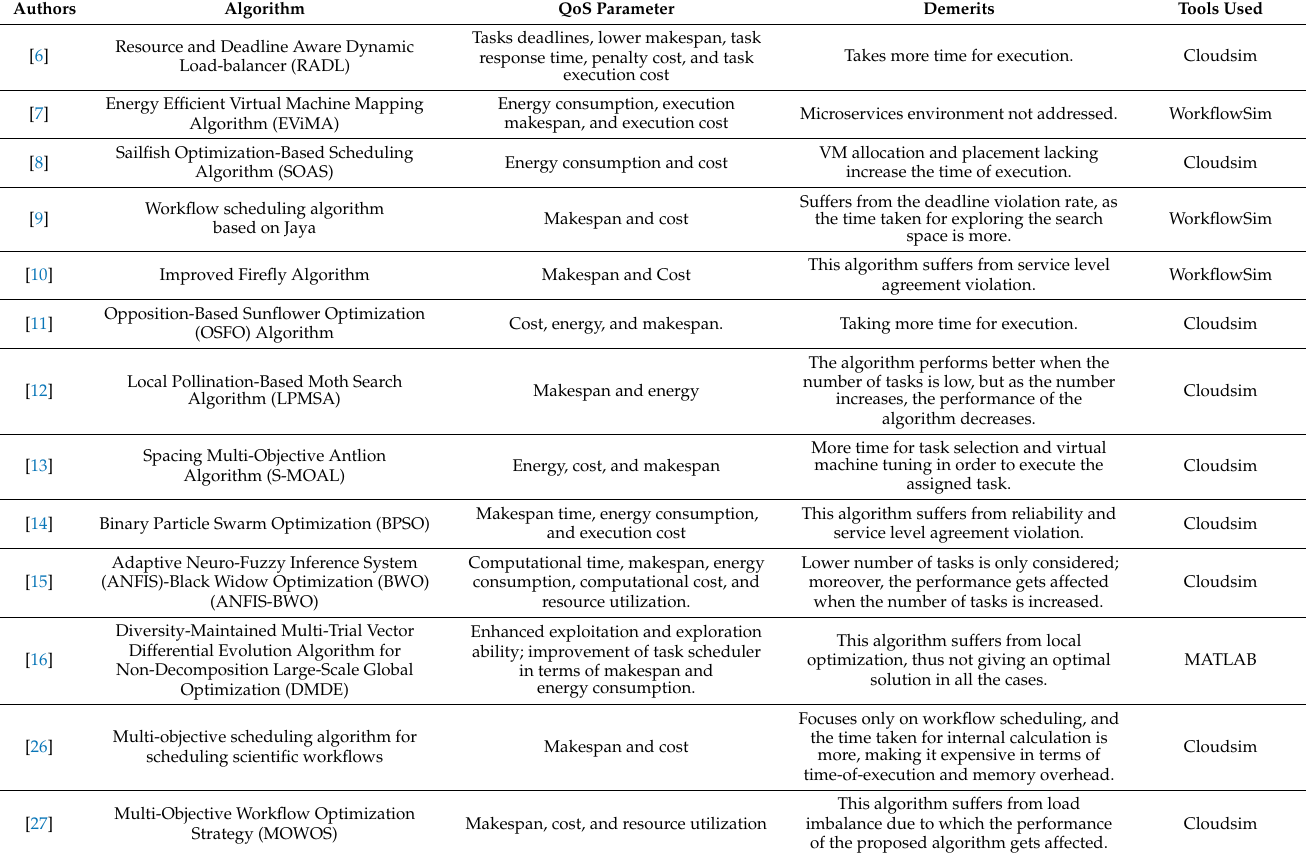
Table 1. Comparative table for literatures